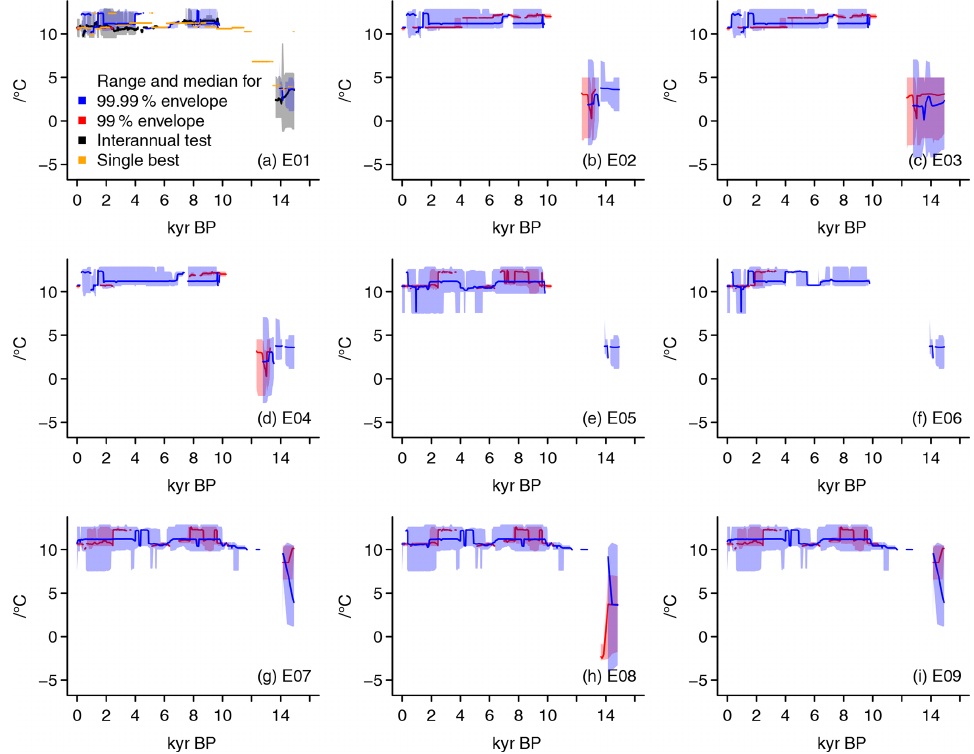
Figure 11. Visualizing the reconstructions for the various proxy setups: (a) E01, (b) E02, (c) E03, (d) E04, (e) E05, (f) E06, (g) E07, (h) E08, (i) E09. All panels include the median and the full range for the reconstructions under a 99% tolerance envelope (red) and a 99.99% envelope (blue). Panel (a) additionally includes a setup in black where we do not consider 101-year moving averages of simulation data but all simulation output as provided including the FAMOUS-HadCM3 simulations for QUEST. Orange points in panel (a) are for a test considering only the single best analogues for each